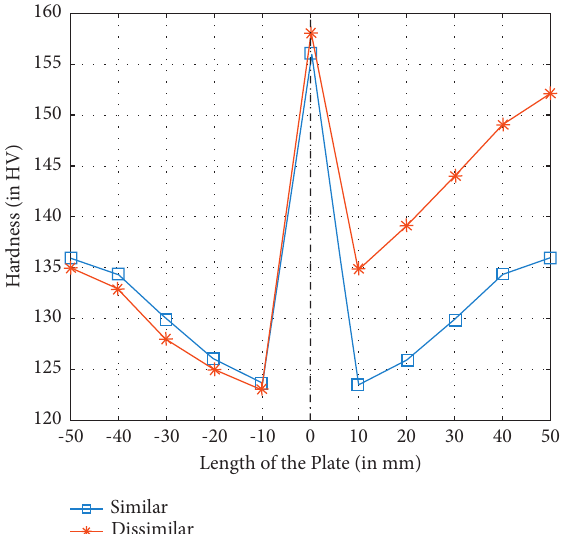
Figure 19: Vickers hardness vs. length of plate in double V groove weld specimen.